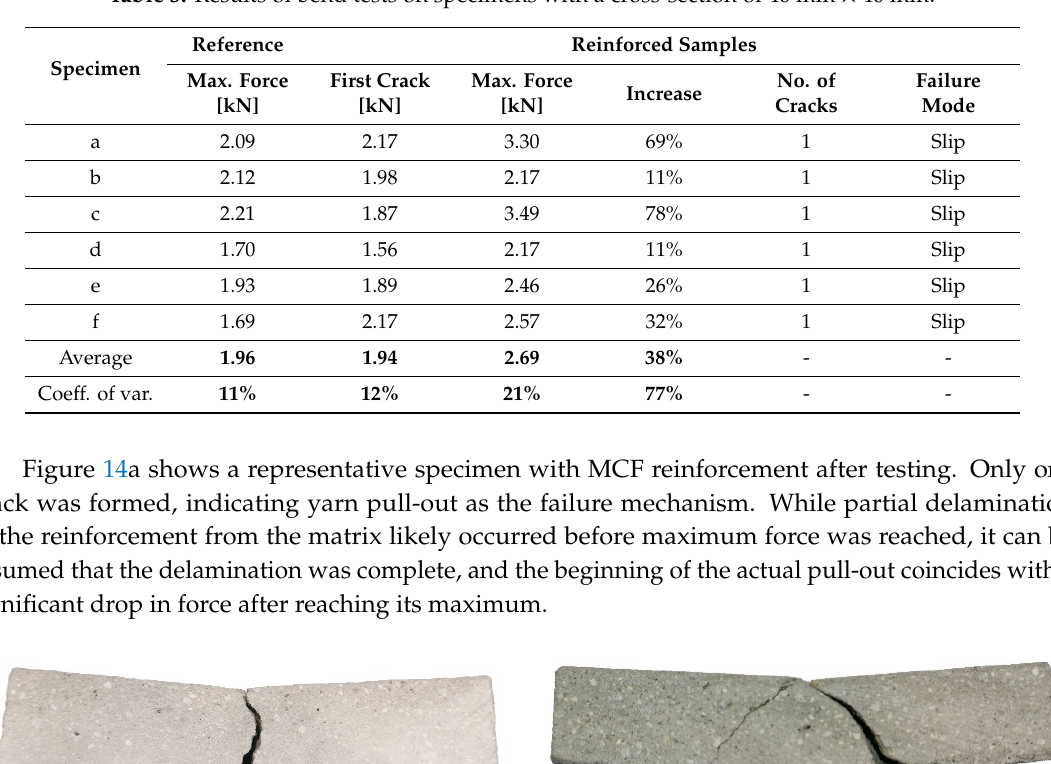
. Figure 15. Representative force–displacement curves for specimen with a cross-section of 25 mm x 20 mm. The observed final failure mode was delamination and spalling of the concrete cover, which was accompanied by a yarn pull-out; see Figure 14b. Mostly due to the poorly defined failure, the calculation of the tensile force in the reinforcement F t,MCF could not be performed here. 0.00.51.0 1.52.02.53.03.54.0 0.0